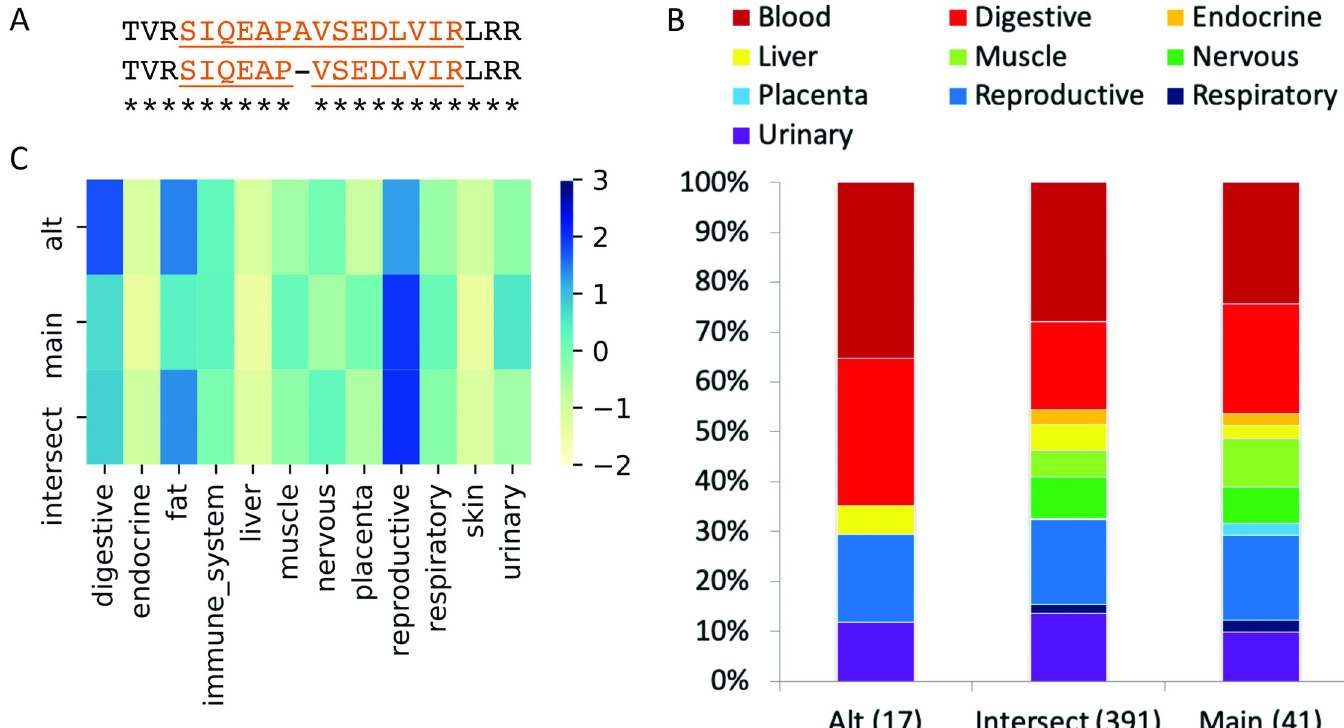
Fig 8. Group-specific splicing in gene TOR1AIP1 . (A) We found peptide evidence for a single primate-derived splice event for TOR1AIP1 . This NAGNAG splicing event resulted in the loss/gain of a single amino acid. The discriminating peptides we detected are highlighted. (B) The distribution of the PEDs for the discriminating peptides (“Alt” and “Main”) and the remaining peptides that mapped to TOR1AIP1, but that did not distinguish one isoform from the other (“Intersect”). The number of PEDs in each set is shown in brackets. Fisher tests show that the distributions of PEDs between the Main and Alt peptides are not significantly different over any of the ten tissue groups. (C) The group-specific distribution of reads that support each side of the splice junction (main, alt) and those that support remaining common protein sequence (intersect) coloured by standard deviation from the mean; the darker the colour, the greater the positive standard deviation. There is more than one standard deviation between the reads for the digestive and reproductive groups, so the TOR1AIP1 event is determined to be group specific at the transcript level for these tissue groups.